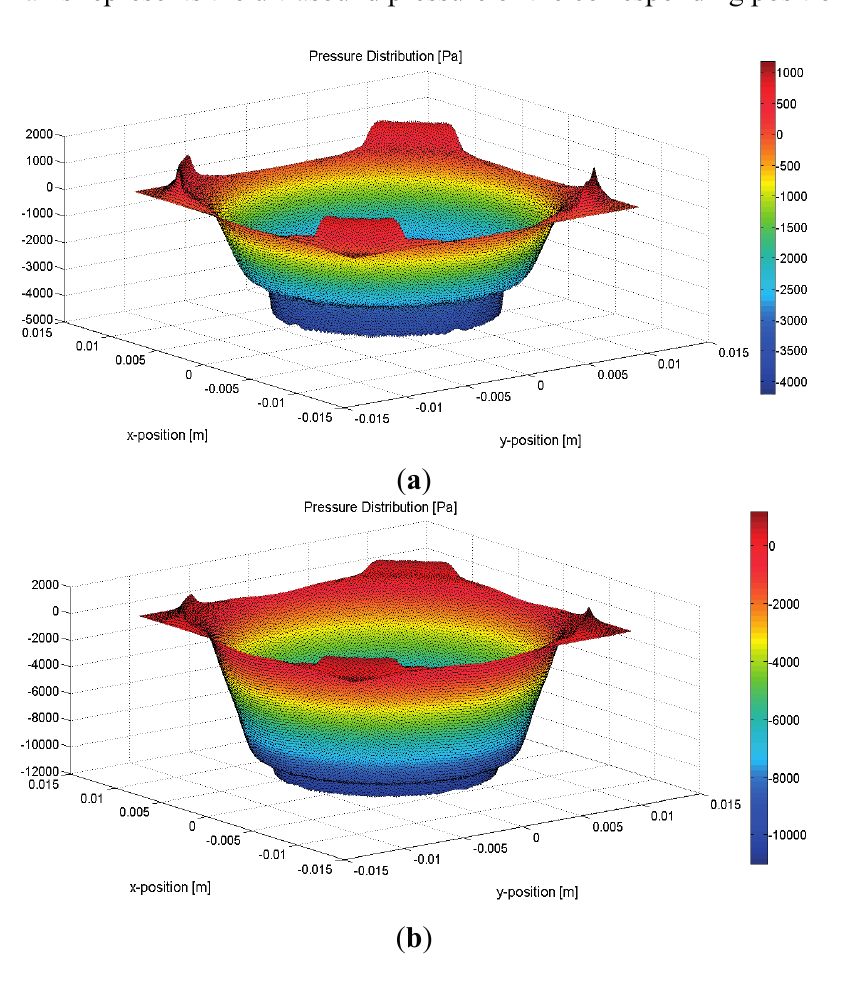
Figure 4. Ultrasound pressure distributions of the remaining waves for ( a ) the two-layer sensor after attenuation, and ( b ) the one-layer sensor after